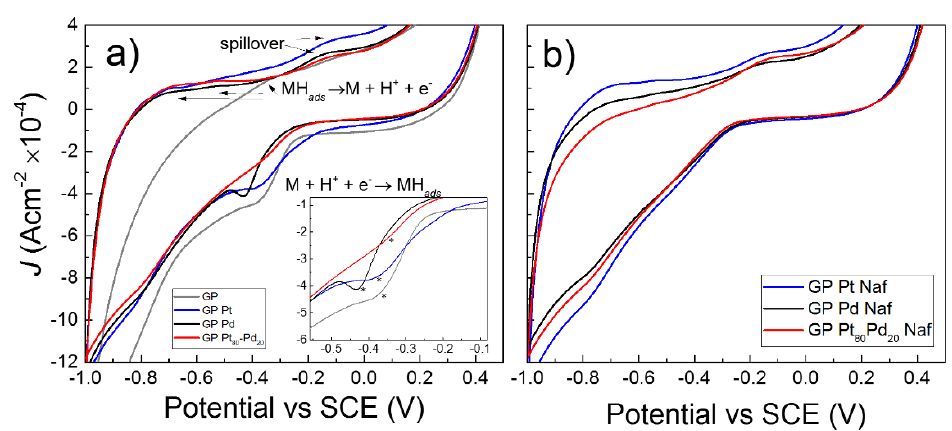
Figure 7. a ) Cyclic voltammograms of GP and NPs-GP; b ) cyclic voltammograms of NPs-GP obtained by suspension in water 025% wt. Nafion. Conditions: KOH 1 M; scan rate 20 mVs − 1 . The inset shows the peak position of hydrogen ion adsorption and reduction, marked by asterisk.